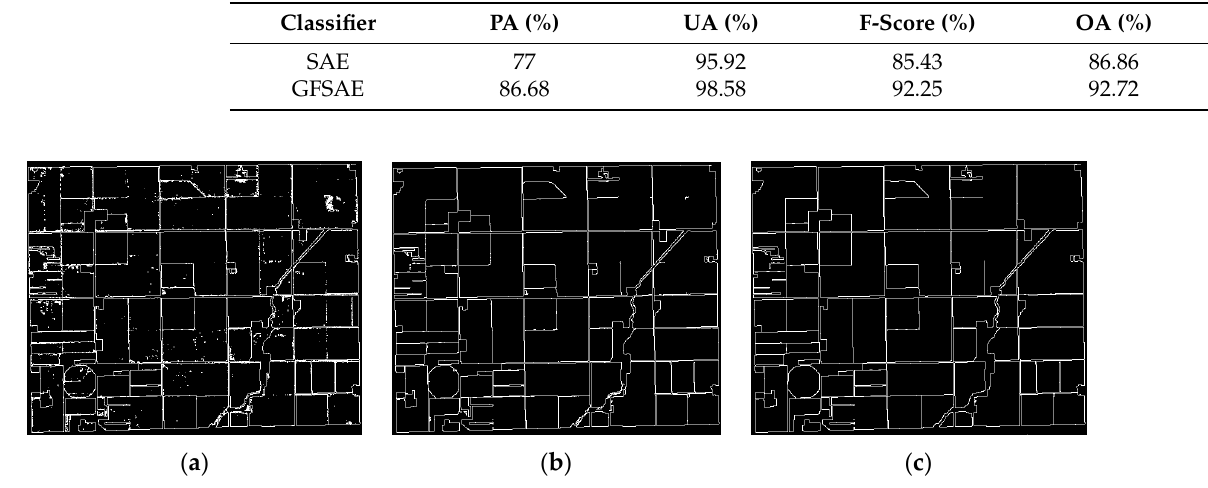
Figure 13. Field boundaries from ( a ) SAE ( b ) GFSAE ( c ) ground truth for the Winnipeg dataset. Comparing the boundary maps of SAE and GFSAE with ground truth proves the high potential of the proposed method in field boundary extraction. Similar to the CEF dataset, applying a guided filter in the Winnipeg dataset eliminates redundant edges in the SAE map and adds missing edges. Figure 14 shows the proposed method’s confusion matrix compared with SAE.